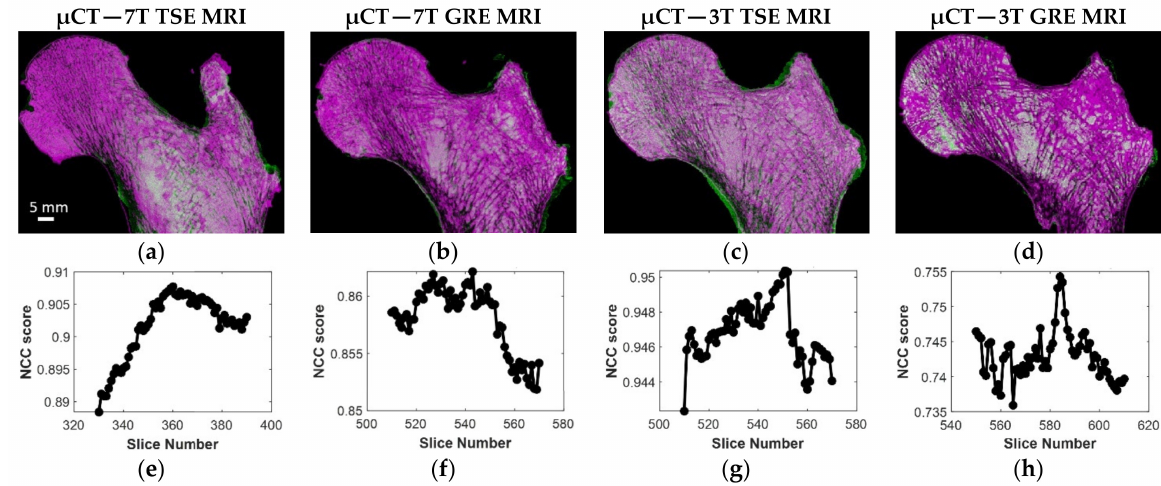
Figure 5. ( a – d ) S1 best registration for the four different MRI acquisitions with µ CT; ( e – h ) corresponding NCC efficiency profile.